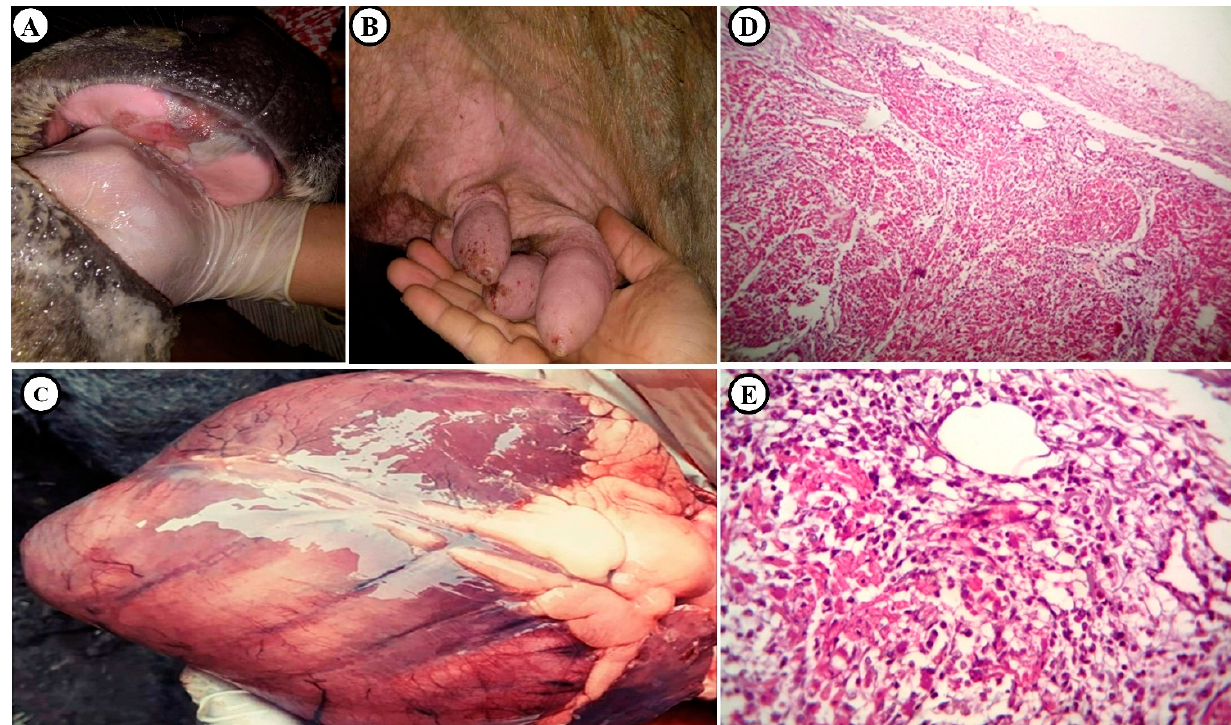
Figure 3. Clinical and histopathological signs in FMD-infected buffaloes. ( A ) Blisters and ulcers in the dental pad. ( B ) Blisters in teats. ( C ) Heart of buffalo showing grayish-white stripping, particularly in the left ventricle near the septum (Tiger heart). ( D ) Heart of buffaloes showing pericarditis and myocarditis ×120 H&E; and ( E ) Heart of buffaloes showing non-suppurative myocarditis characterized by replacement of necrotic cardiac myocytes by edema, lymphocytes, and some plasma cells ×400 H&E.